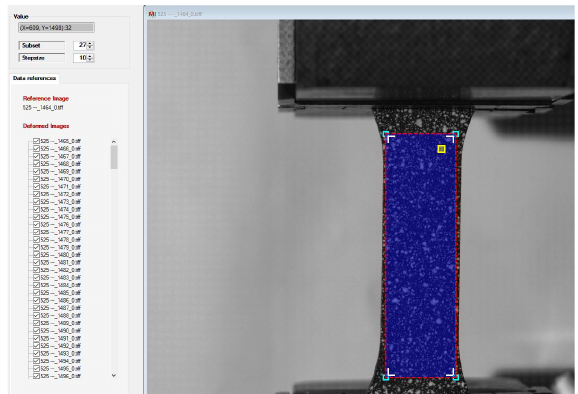
Figure 1. Defining the region of interest in software